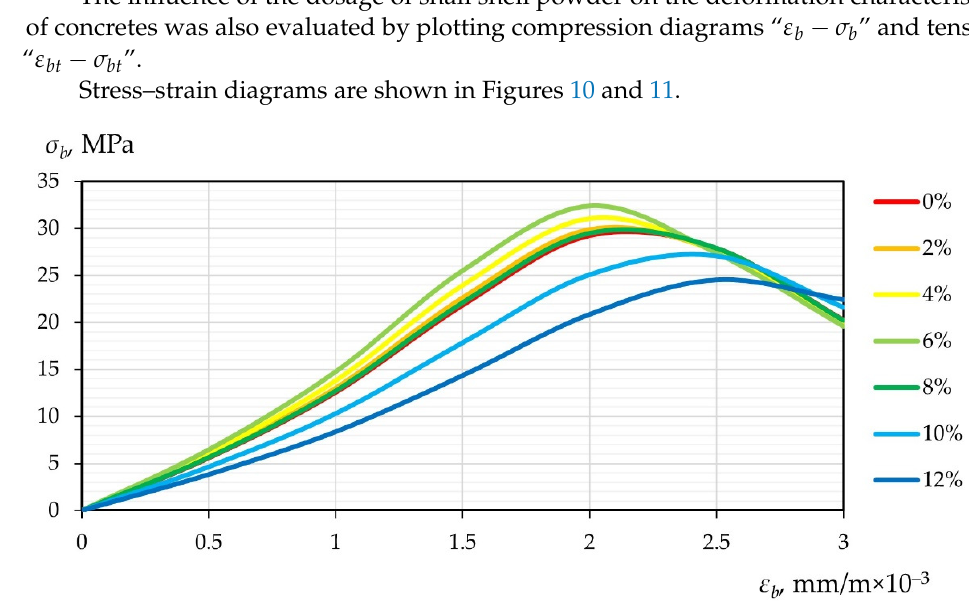
ε σ− ” and tension b b